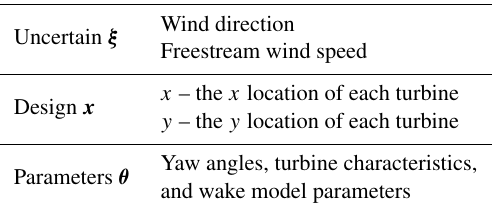
Table 1. The variables used for calculating the